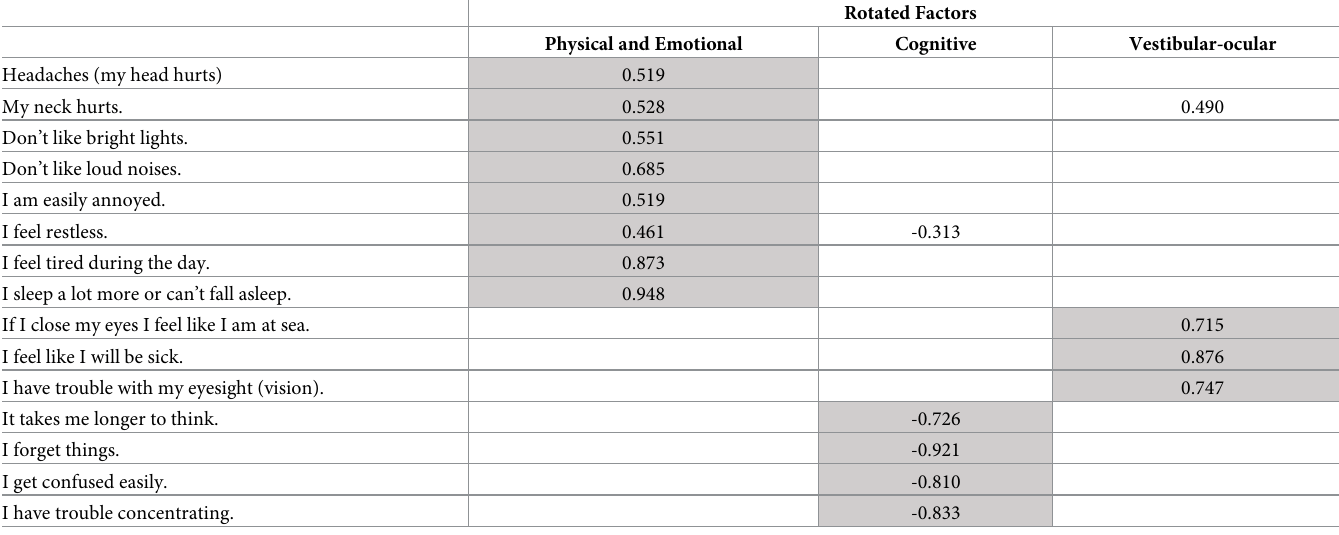
Table 4. Item loadings on the three factors of the